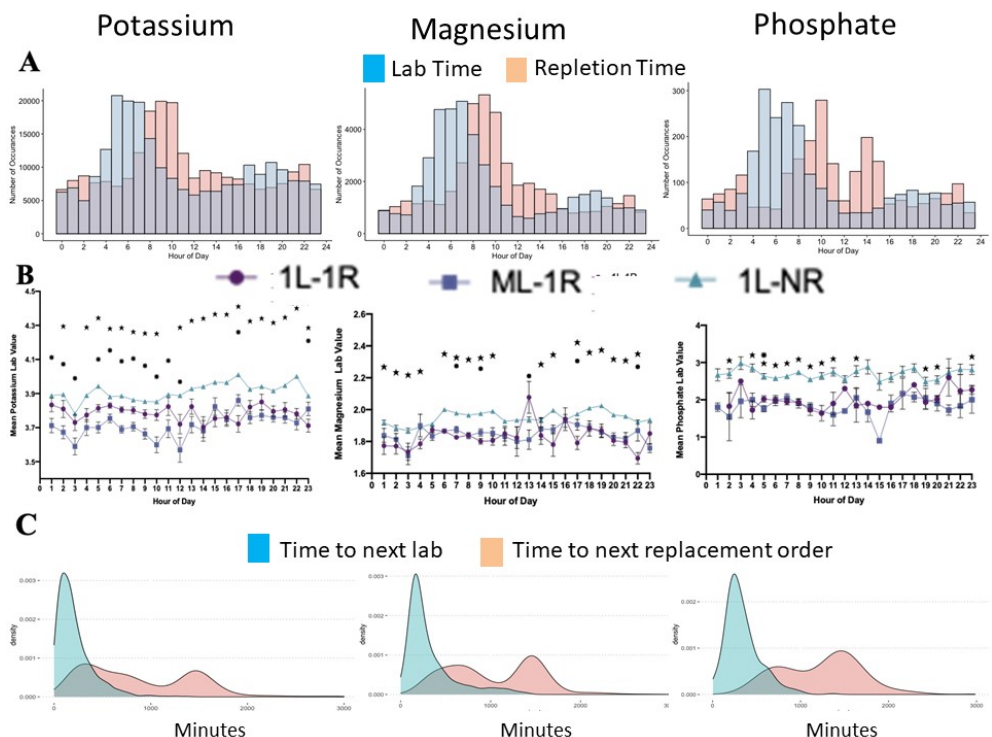
Figure 5. When the electrolyte order was placed, the lab value and replacement seemed to follow hospital routine ( A ). However, the threshold did not fluctuate considerably over 24 hours, and the most significant difference in the threshold was when multiple lab values preceded the electrolyte replacement order ( B ). The follow-up lab values were executed in bimodal distribution ( C ), but the peaks depended on electrolyte type.